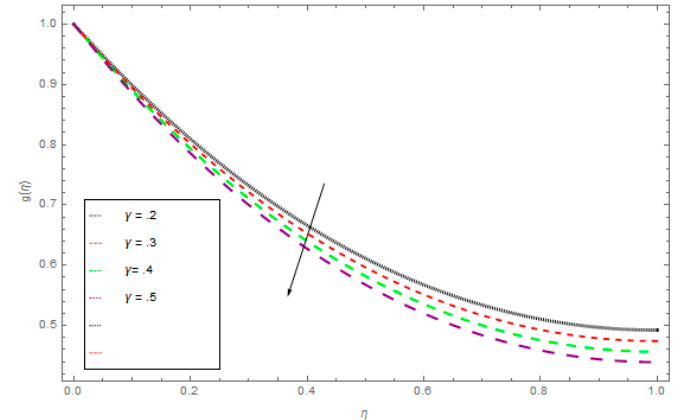
Figure 2. The influence of γ on f ( η ) when Ω = 1, ρ = 1, σ = 0.5, k = 1, M = 1.